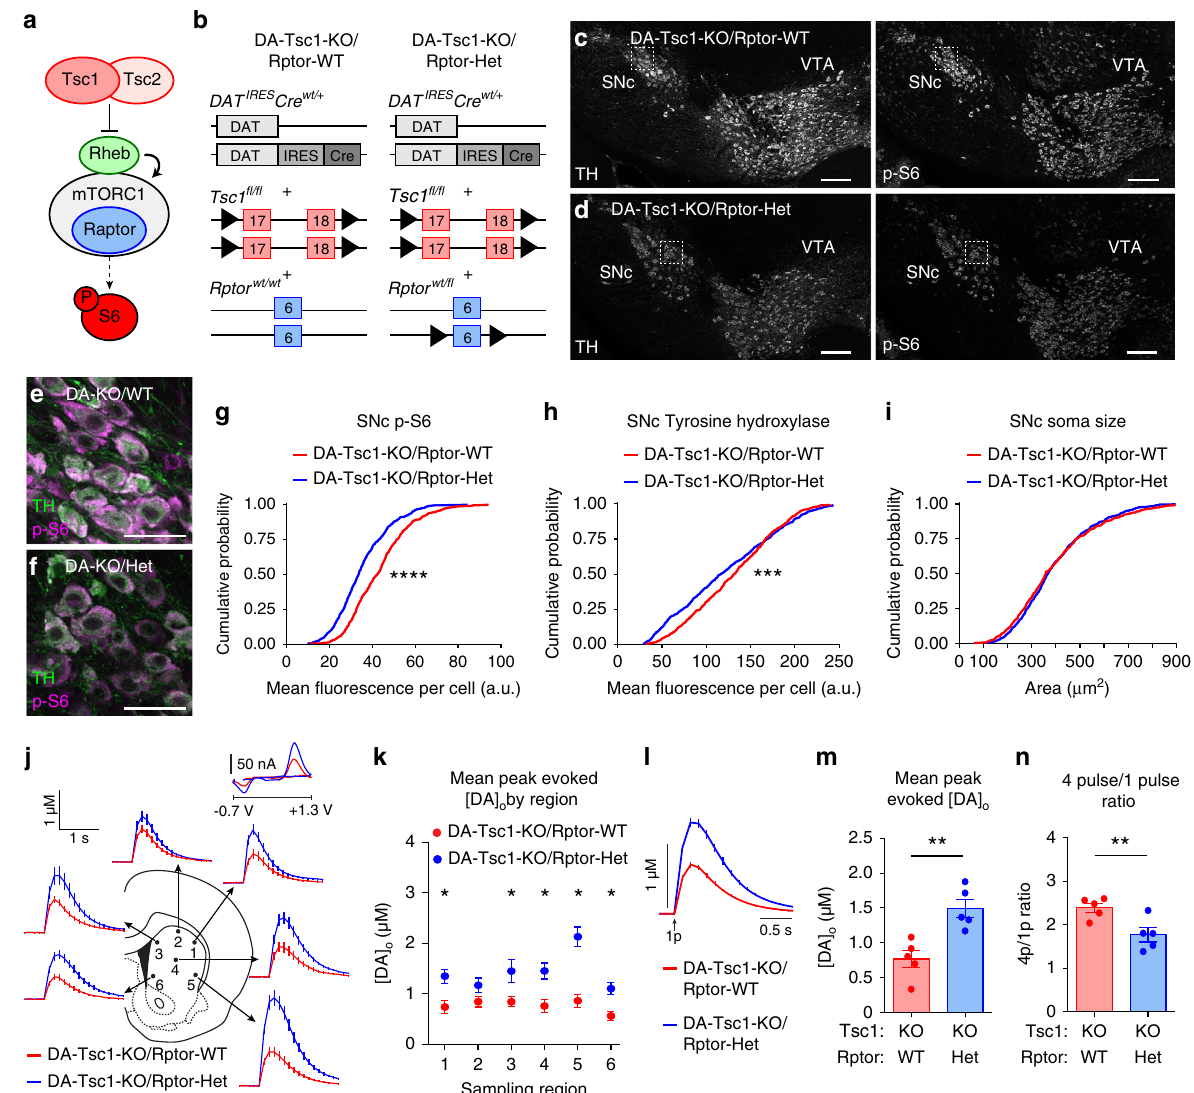
Fig. 8 Heterozygous Rptor deletion prevents DA release de fi cits in DA-Tsc1-KO mice. a Simpli fi ed mTORC1 signaling schematic showing the Tsc1/2 heterodimer as a negative regulator of the small GTP-ase Rheb, which directly promotes mTORC1 kinase activity. Raptor is an essential component of mTORC1. b Schematic of the genetic strategy to selectively delete Tsc1 and reduce Rptor by one copy in DA neurons. c – f Confocal images of midbrain sections from DA-Tsc1-KO/Rptor-WT ( c , e ) and DA-Tsc1-KO/Rptor-Het ( d , f ) mice immunostained for tyrosine hydroxylase (TH) and phosphorylated S6 (p-S6, ser240/244), scale bars = 200 μ m. e , f show higher magni fi cation merged images of the boxed regions in c , d , scale bars = 50 μ m. g – i Cumulative distributions of SNc DA neuron p-S6 levels ( g ), tyrosine hydroxylase levels ( h ), and soma area ( i ) (DA-Tsc1-KO/Rptor-WT: n = 509 neurons from three mice, DA-Tsc1-KO/Rptor-Het: n = 567 neurons from three mice). **** p < 0.0001; *** p = 0.0003, Kolmogorov – Smirnov tests. j Mean ± SEM [DA] o versus time evoked by a single electrical pulse from different dorsal striatal subregions. Traces show an average of 17 – 20 transients per recording site from 5 mice per genotype. Inset, typical cyclic voltammograms show characteristic DA waveform. k Mean ± SEM peak [DA] o by striatal region (numbers correspond to the sites in j ). n = 17 – 20 transients per recording site from fi ve mice per genotype. * p 1 = 0.0002; * p 3 = 0.0.0150; * p 4 = 0.0033; * p 5 < 0.0001; * p 6 = 0.0005, paired two-tailed t tests. l Mean ± SEM [DA] o versus time for all dorsal striatum sites (sites #1 – 6). Average of 111 – 112 transients across six recording sites per genotype from fi ve mice. m Mean peak ± SEM [DA] o averaged across all dorsal striatum sites (sites #1 – 6). n = 5 mice per genotype. ** p = 0.0087, paired two-tailed t test. n Mean ± SEM ratio of peak [DA] o evoked by a four-pulse train to single-pulse stimulation in the dorsolateral striatum. n = 5 mice per genotype. ** p = 0.0062, paired two-tailed t test. For m , n , dots represent values from individual mice. See also Supplementary Figs. 7 and 8. Source data are provided as a Source Data fi